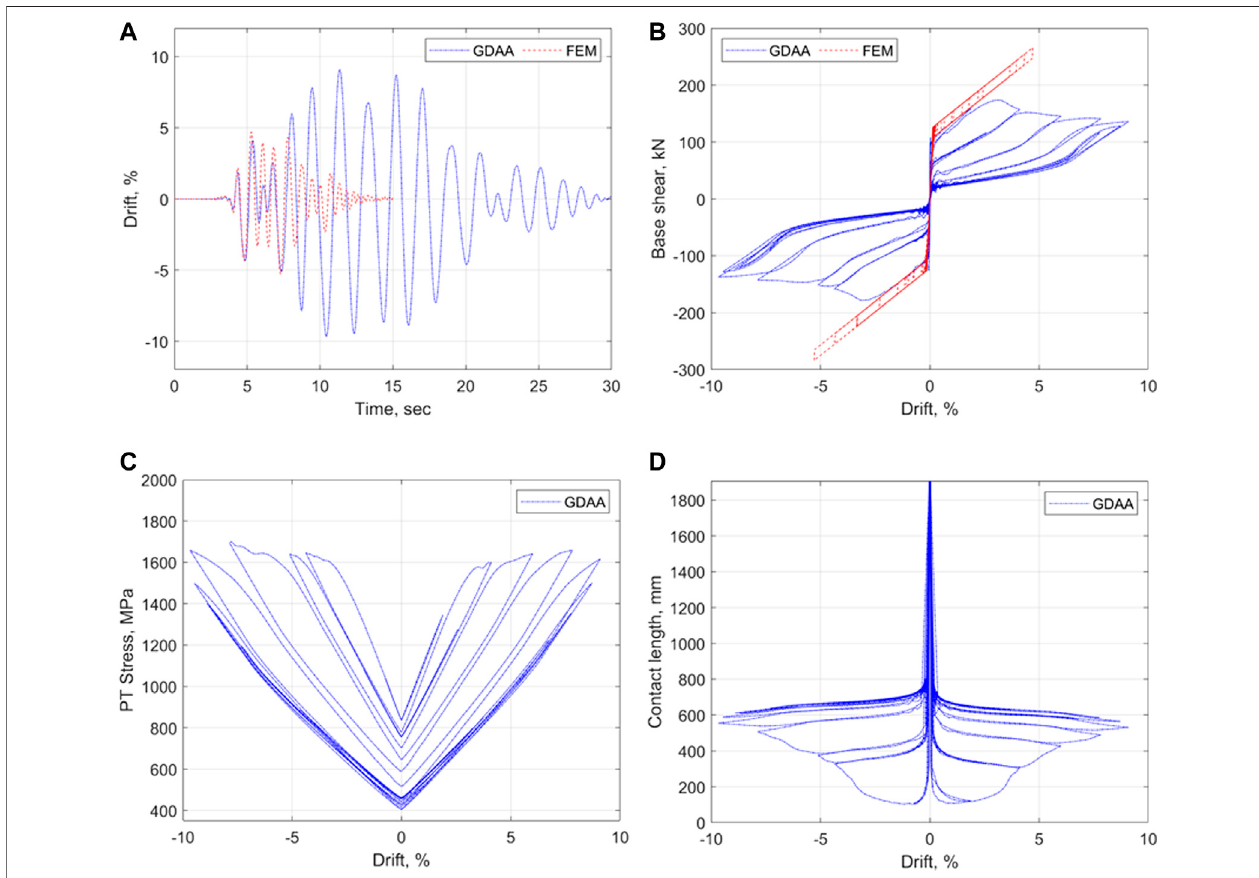
FIGURE10| Responses ofSRW2tothehorizontal component ofSylmarasmodeledbytheGDAAand theFEM: (A) Timehistoryoflateraldrift; (B) baseshearvs. lateral drift; (C) PT Stress vs. lateral drift; (D) Contact Length vs. lateral drift.